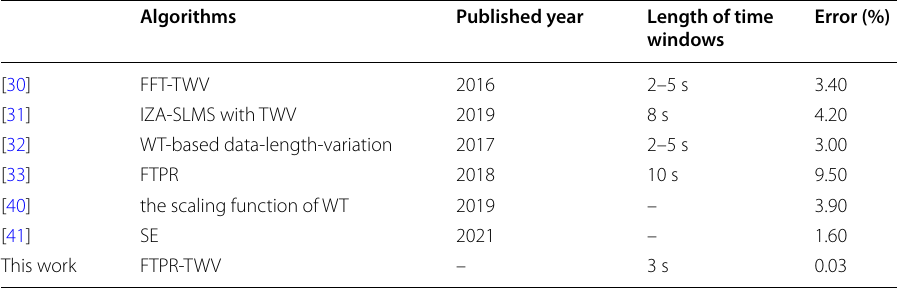
Table 3 Comparison of the HR measurements with different algorithms